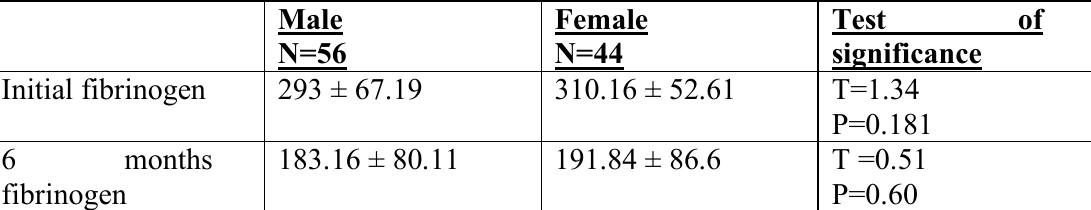
Table(3) fibrinogen according to gender